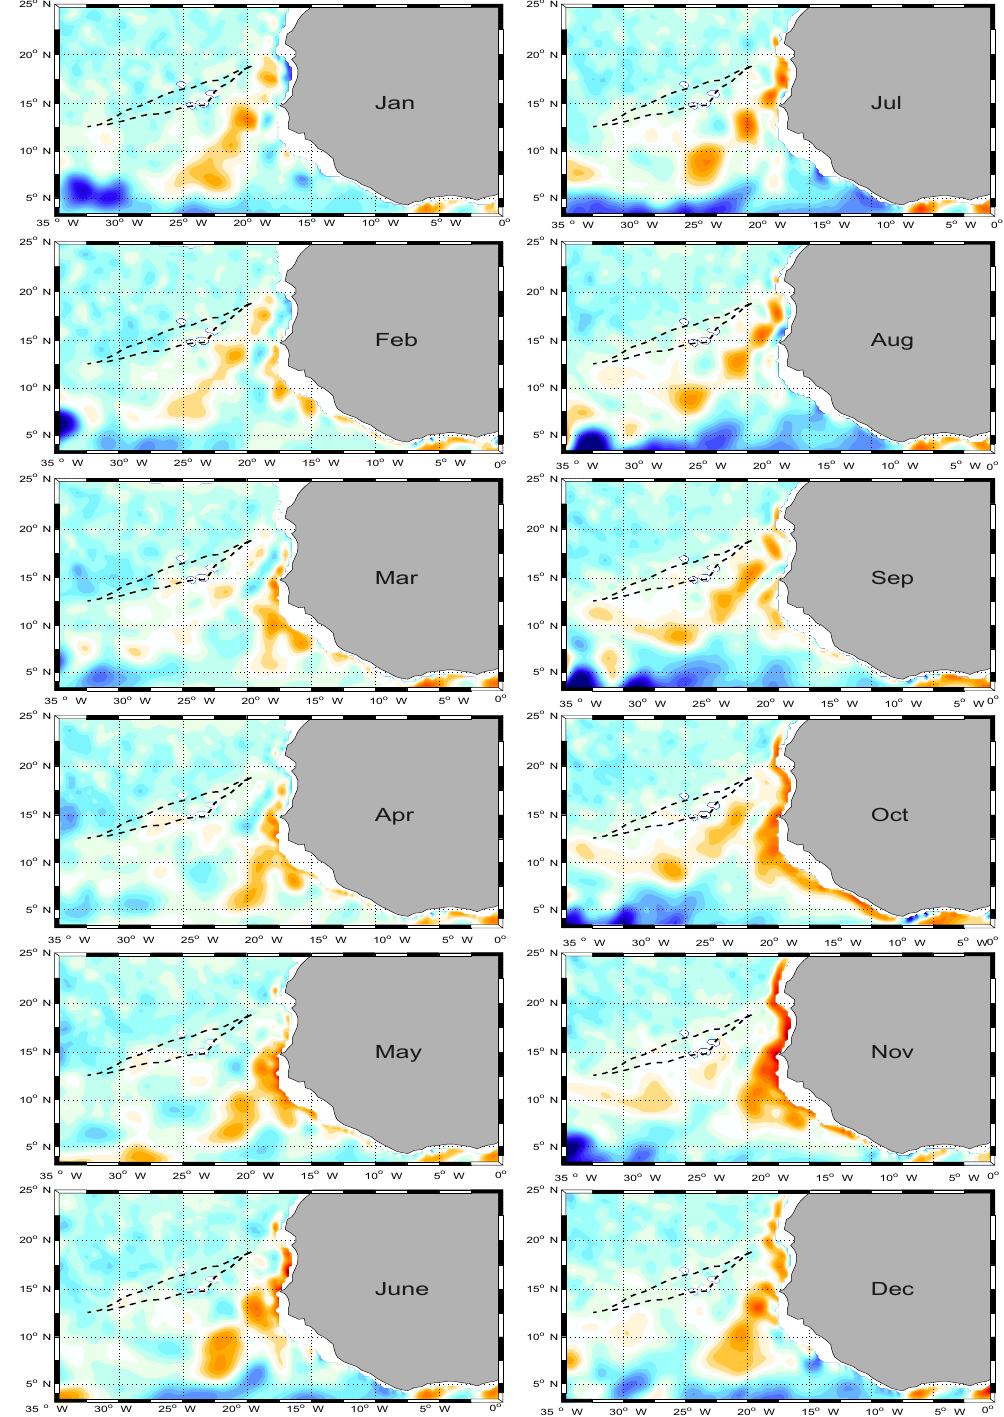
Figure 10. Monthly climatology of meridional transport (m 2 s − 1 ) integrated between the isopycnal surfaces σ t = 26 . 7 and the surface, excluding wind-driven Ekman transport calculated from TROP025 wind fields. The two thin dashed lines represent the location where zero PV gradients are found in Fig.